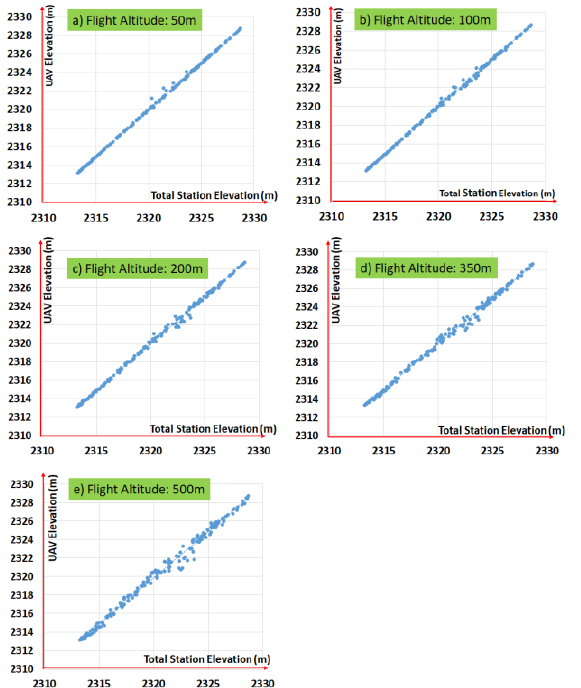
Figure 8: Scatter plot of correlation between DSM total station and UAV DSM at diverse altitudes: a) 50m, b) 100m, c) 200m d) 350m, e) 500m